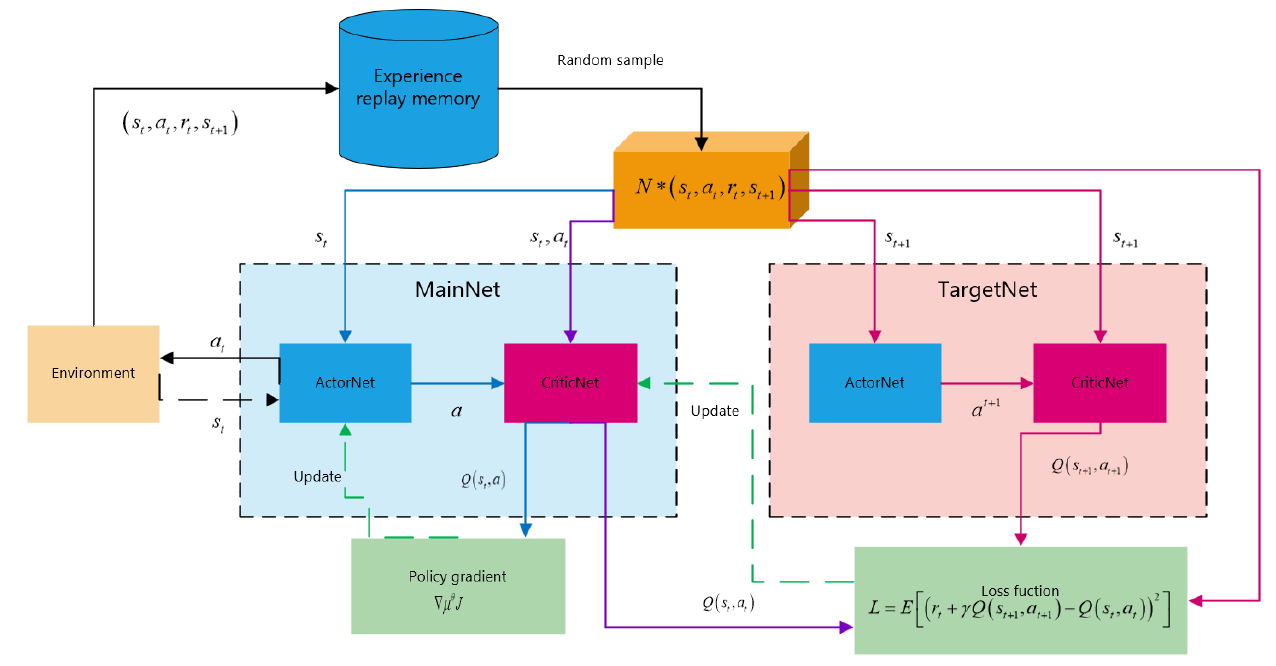
Figure 13. Deep Deterministic Policy Gradient (DDPG) algorithm structure. Based on DPG, DDPG uses deep neural networks. A multilayer feed-forward network with enough neurons in hidden layers can approximate any continuous function with arbitrary accuracy [60]. With the deeper network structure, the actor and the critic network can approximate the policy and the value function more accurately. The deeper network complex action space, increasing the number of hidden layers and the number of nodes of each layer may increases the training time of the network, and even lead to the tendency of